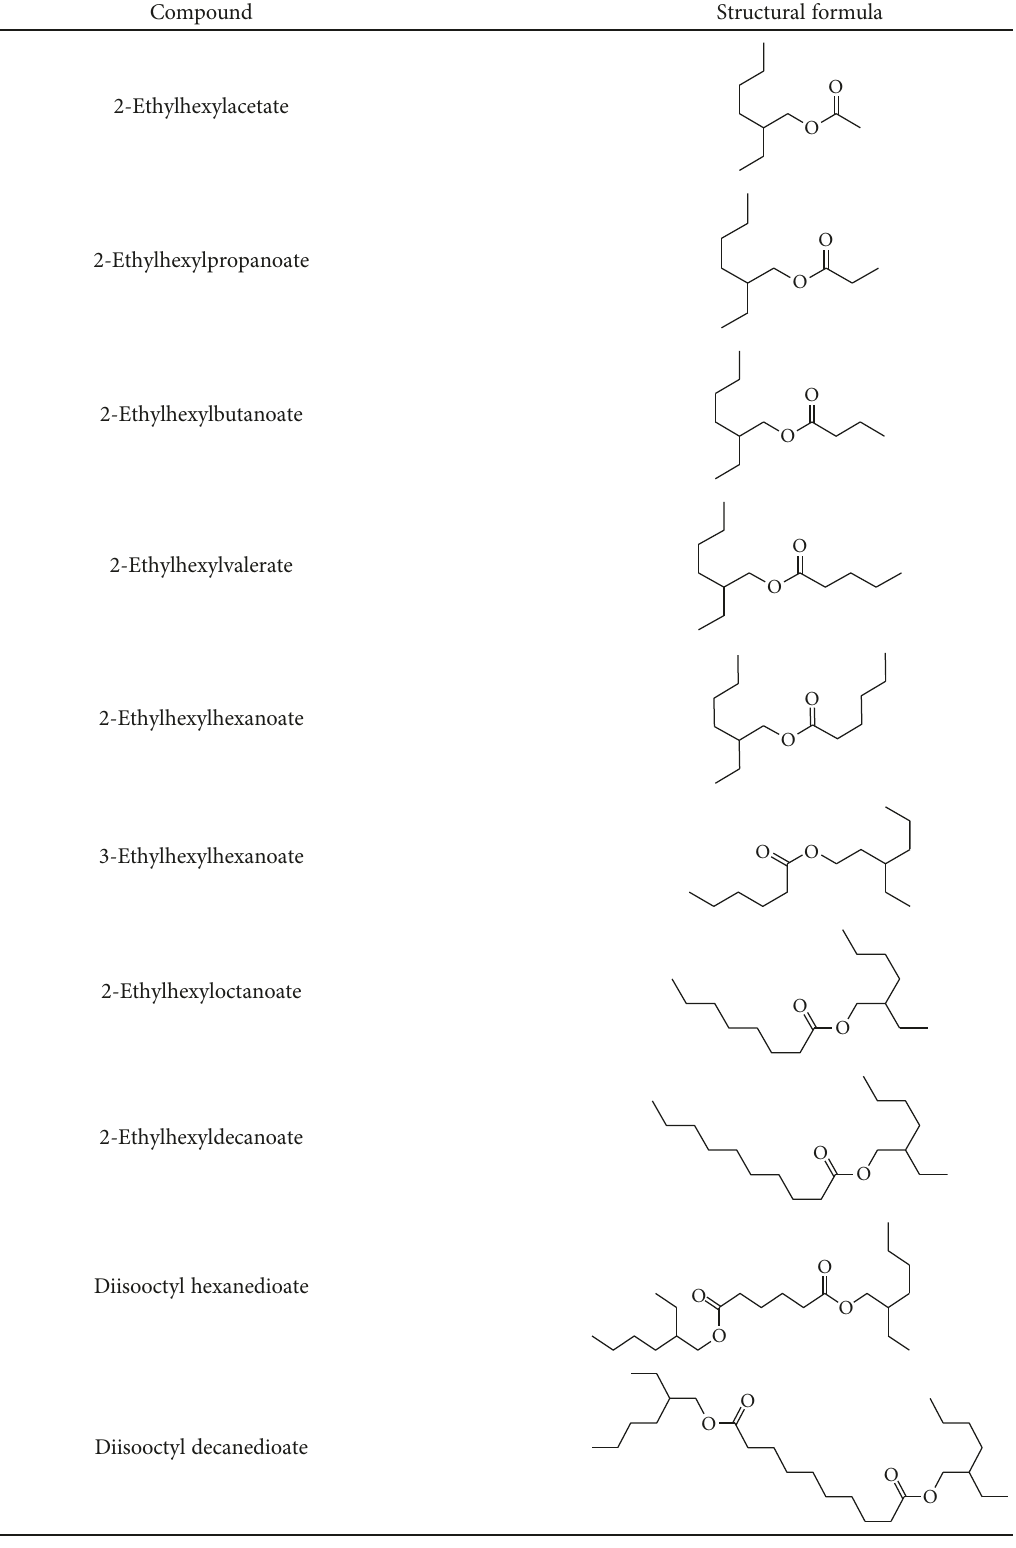
Table 2: Several ester compounds of EO